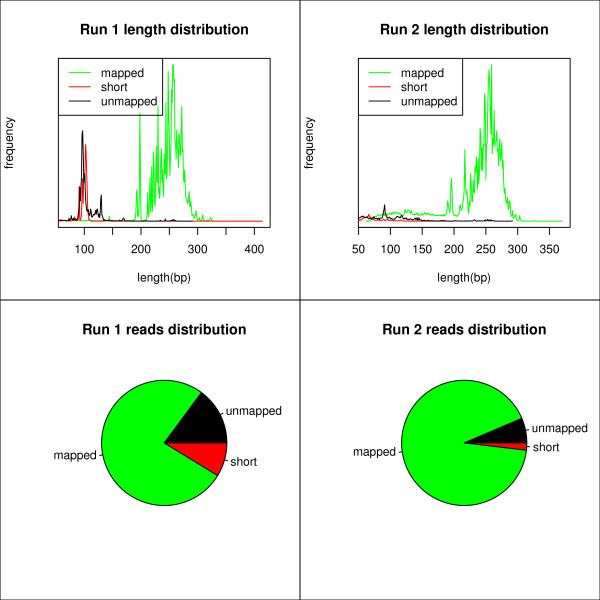
Improving future sequencing efficiency using priors sequencing data. Example of the reporting possibilities. Run 1 had many unmappable and short, mapped sequences. Length distribution showed these were mainly 60-120 bp sequences. In Run 2 optimized PCR reactions and an additional length separation were carried out prior to the sequencing with a huge reduction (8% vs. 24%) of unmapped and short sequences and thus improving the cost-effectiveness.